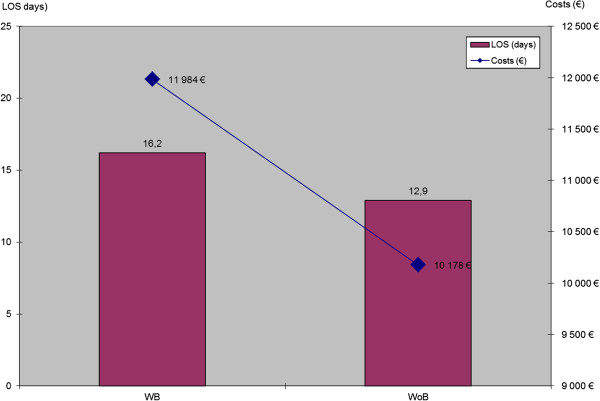
Adjusted mean LOS (p < 0.0001) and Costs (p < 0.0001) according to the WB status.